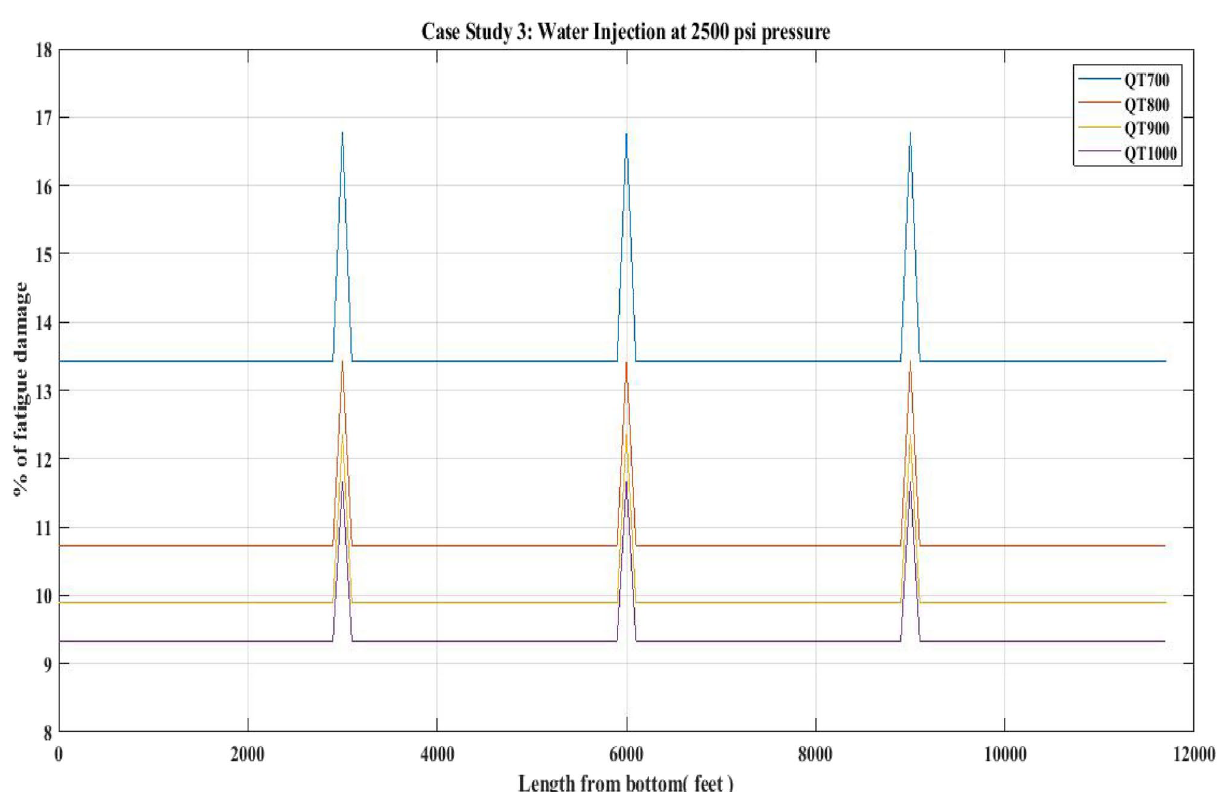
Figure 27. Percentage of fatigue damage with respect to water injection at 2500 psi